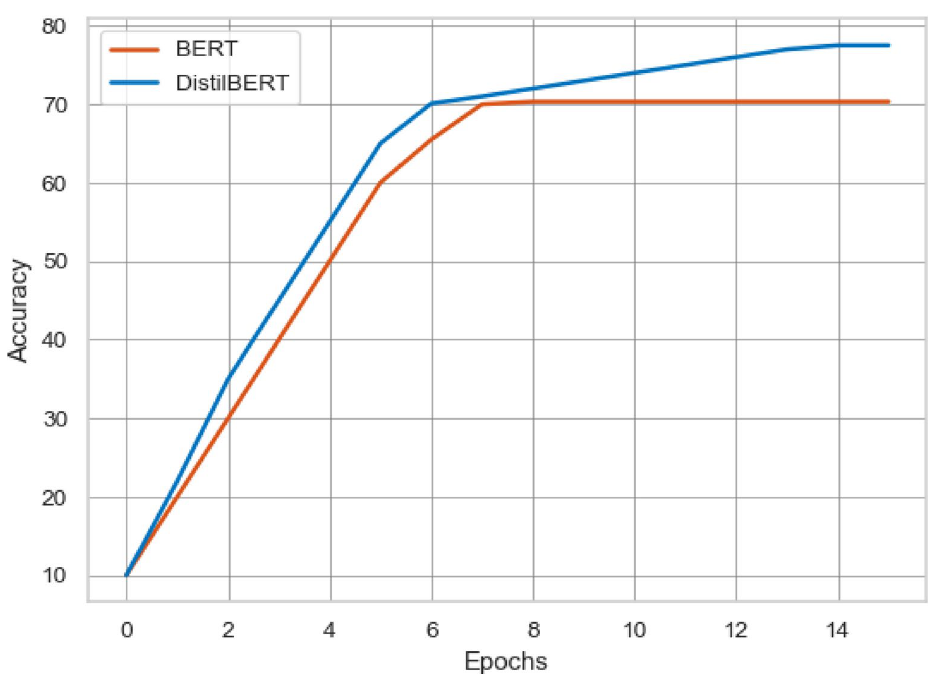
Figure 8. Accuracy comparison of transformer-based models using top 20